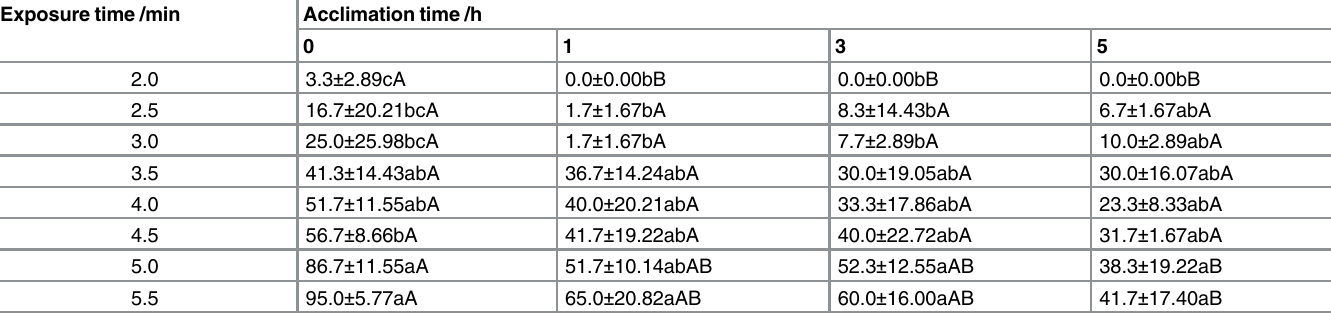
Table 5. The effect of acclimation to sublethal high temperature on mortality (%) of S . zeamais exposed to 51°C. Exposure time /min